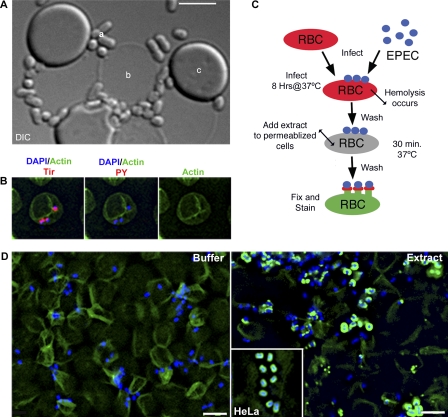
Exposure of RBC to Cytosolic Extract Induces Actin Polymerization beneath Attached EPEC(A) DIC image of EPEC (a) adhering to RBC that had undergone hemolysis (b) or remained intact (c) 6 h after infection.(B) Images of RBC infected with EPEC and stained with DAPI to visualize bacteria (blue), Alexa-488-phalloidin to visualize actin (green), anti-Tir antibody (left panel), and anti-phosphotyrosine (PY) 4G10 antibody (middle panel). Note the lack of PY and actin accumulation beneath the bacteria.(C) Schematic of method used to induce pedestal formation in RBC.(D) Images of EPEC infected RBC after exposure to either buffer or extract for 20 min. Inset in D depicts actin pedestals formed on a HeLa cell infected with EPEC. Cells are stained with DAPI to identify EPEC (blue) and Alexa-488 phalloidin to visualize actin (green). Scale bar in all images represents 5 μm.